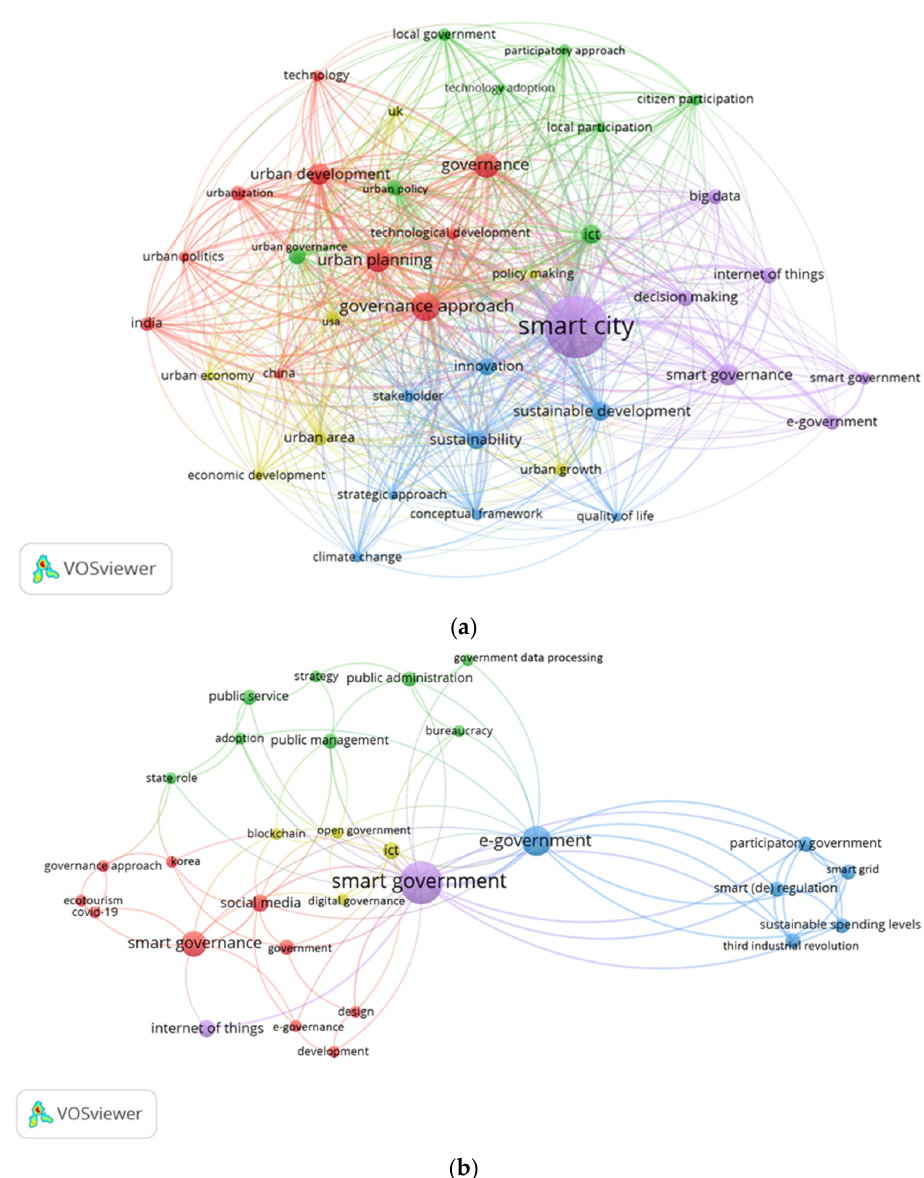
Figure 6. ( a ) Authors’ keyword co-occurrence network (min. 3 occurrences) in SPG smart city re- search. ( b ) Authors’ keyword co-occurrence network (min. 2 occurrences) in SPG smart government